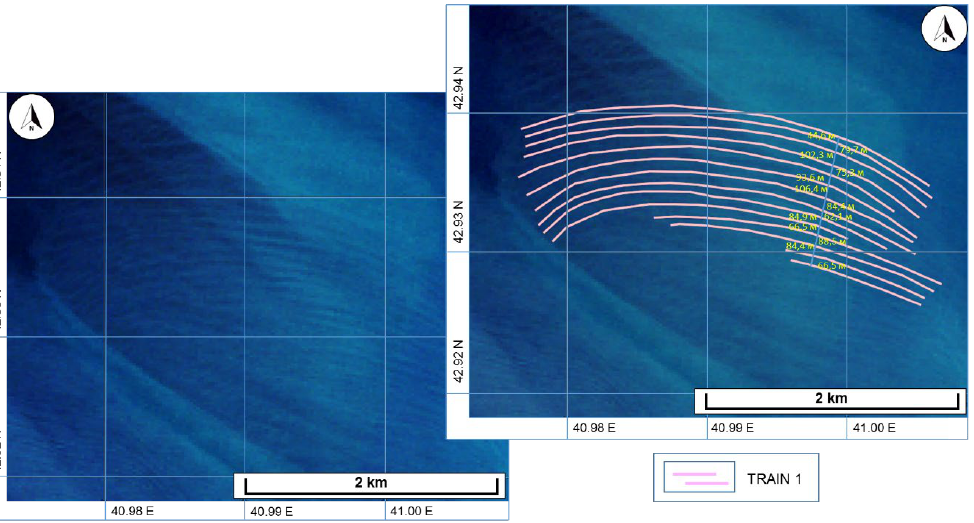
Figure 7. Fragment III of the satellite image (Sentinel-2, 10 September 2017) shows manifestations of a packet of internal waves moving towards Cape Sukhumsky.